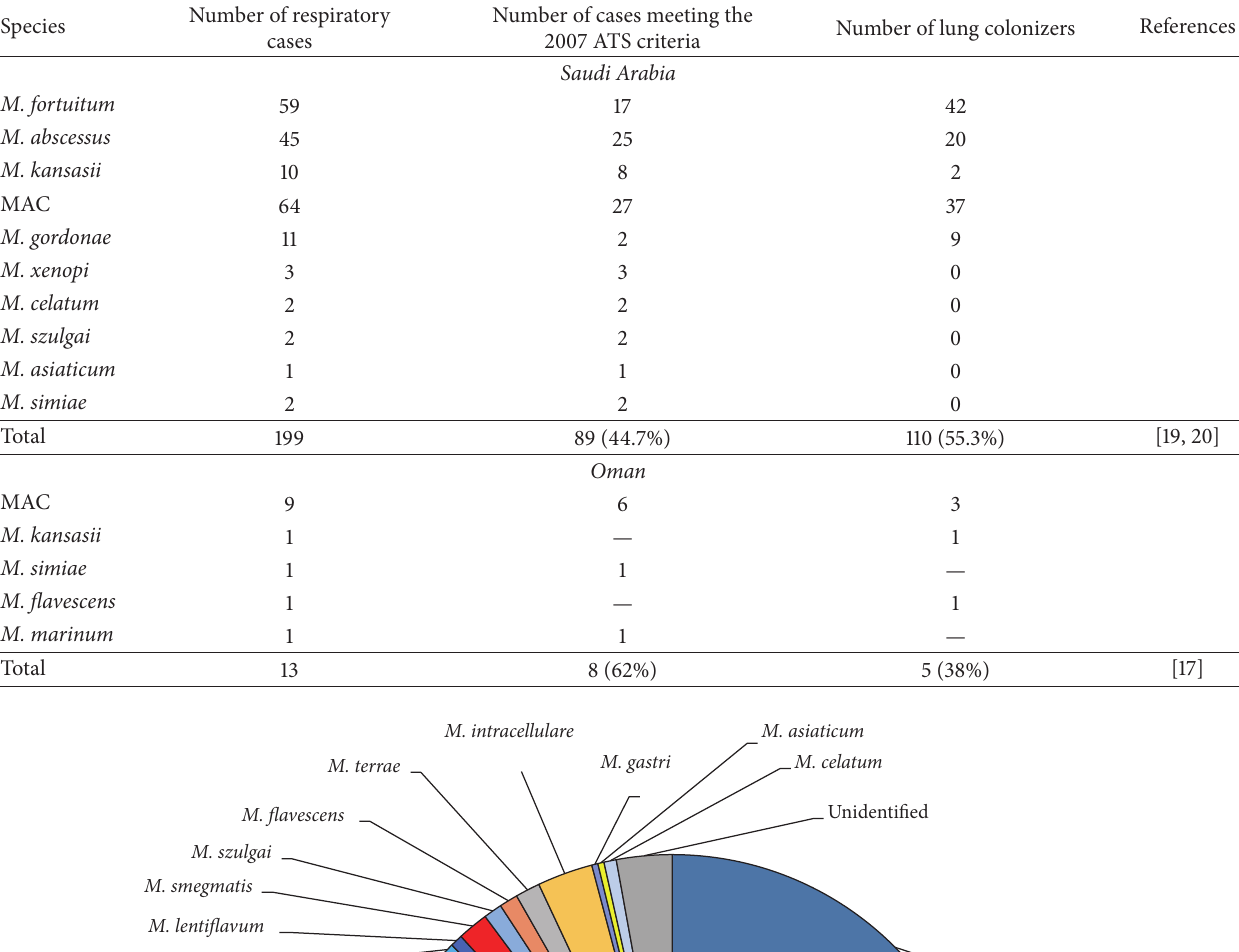
Table 3: Pulmonary infections caused by NTM in Saudi Arabia and Oman.